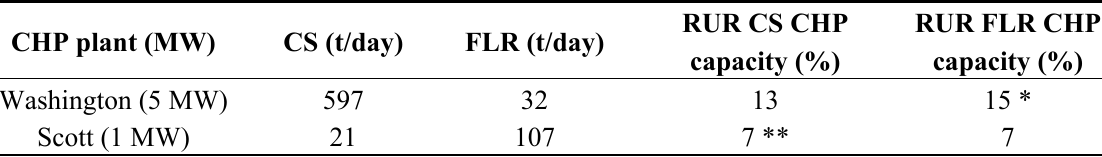
Table 3. Counties with existing CHP facilities, available biomass and required utilization levels to support current CHP capacity.